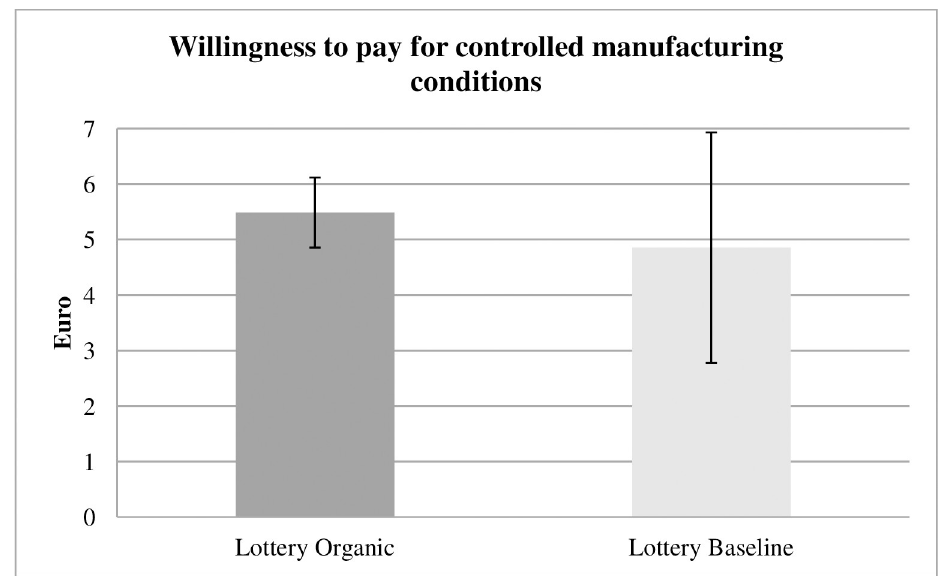
Fig 6. WTP lottery treatments. In the Lottery treatments, the static moral self-licensing effect disappears because there are no significant differences in the WTP for controlled manufacturing conditions. If anything, the pattern reverses based on a